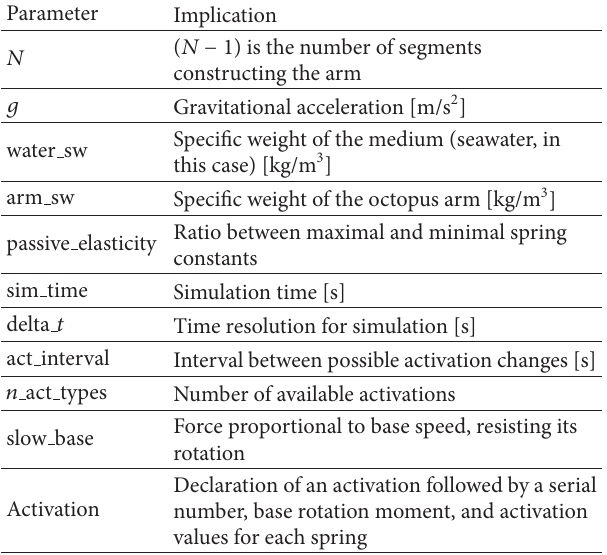
Table 1: Octopus arm simulation